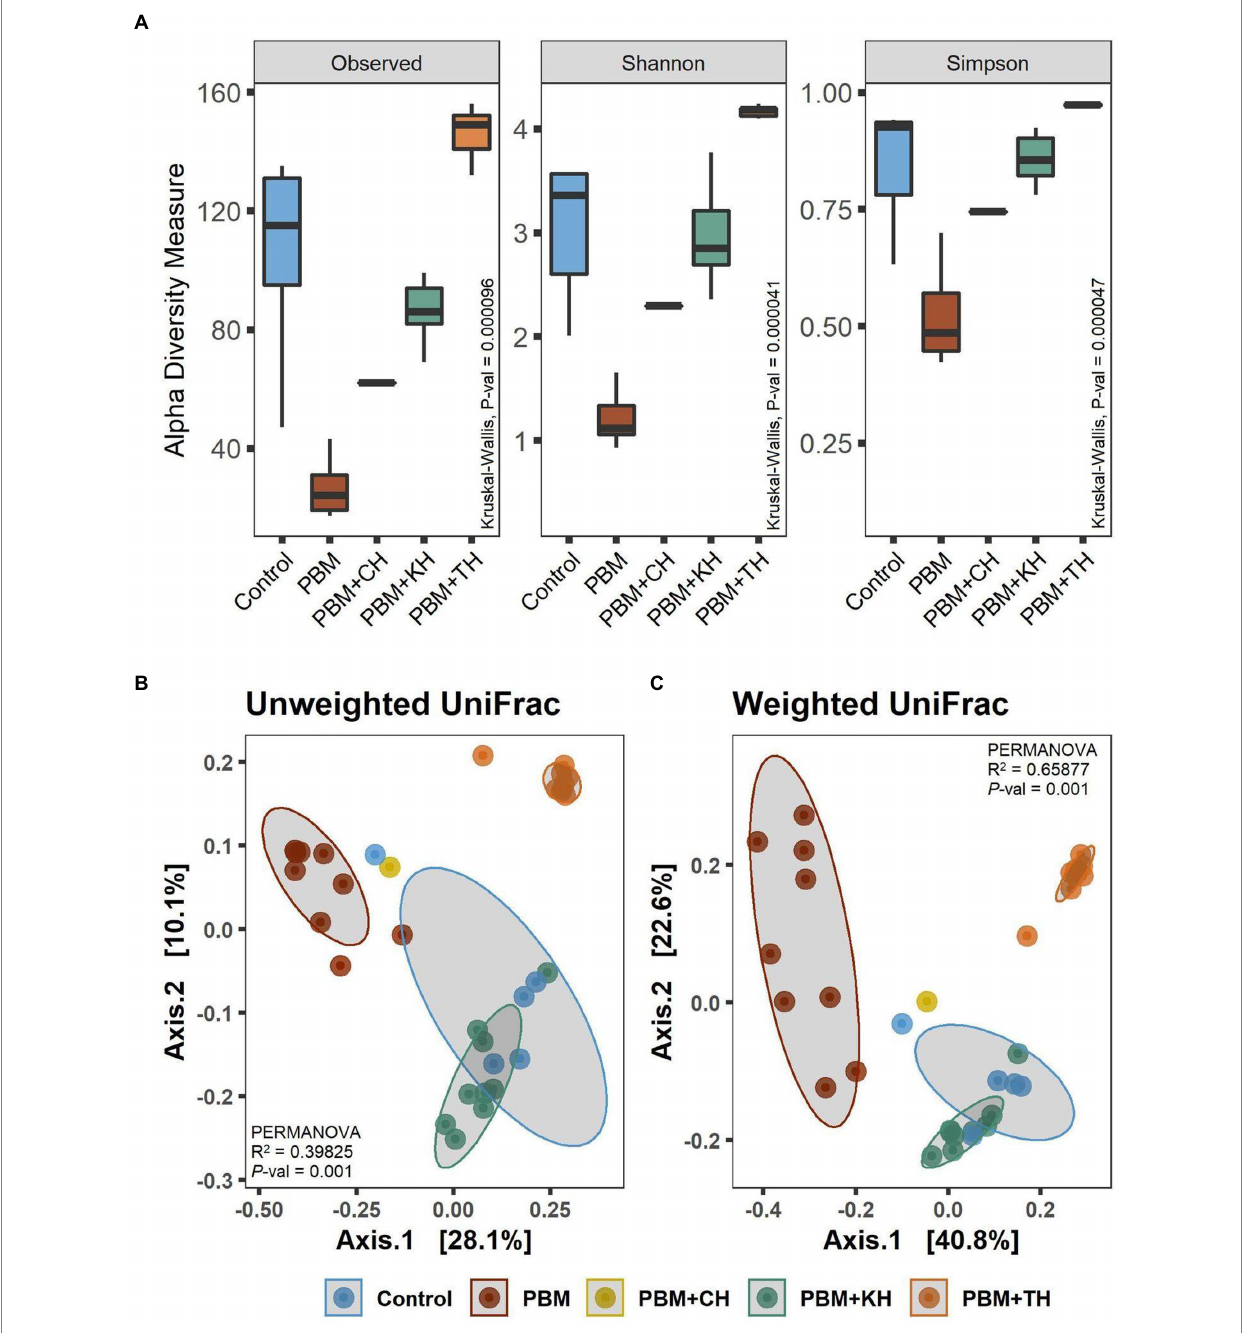
FIGURE 3 Diversity of gut bacteria in barramundi fed FM-based control, PBM alone or supplemented with various FPHs supplemented diet over a period of 42 days. (A) Alpha diversity measurements in terms of Observed, Shannon, and Simpson. (B) Beta-ordination presenting clustering of samples based on unweighted (presence-absence) and weighted (relative abundance) UniFrac distance metric. Kruskal-Wallis with Wilcoxon-rank test for multiple comparisons were used to compare alpha-diversity within groups. Different superscript letters in the boxplot indicate significantly different mean values at value of p <